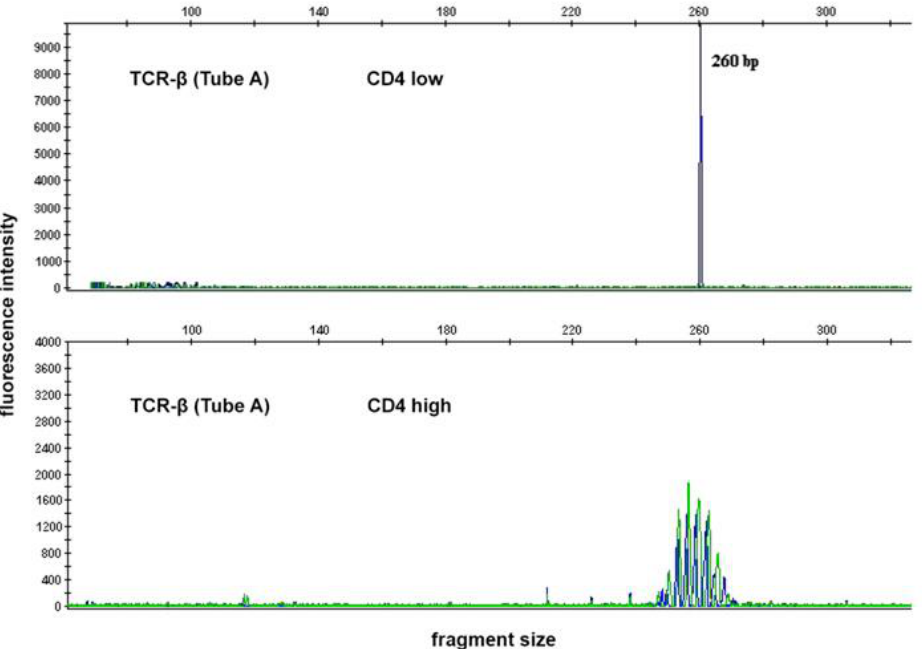
CD4low fraction shows a clonal rearrangement pattern; in contrast, the CD4high fraction shows a